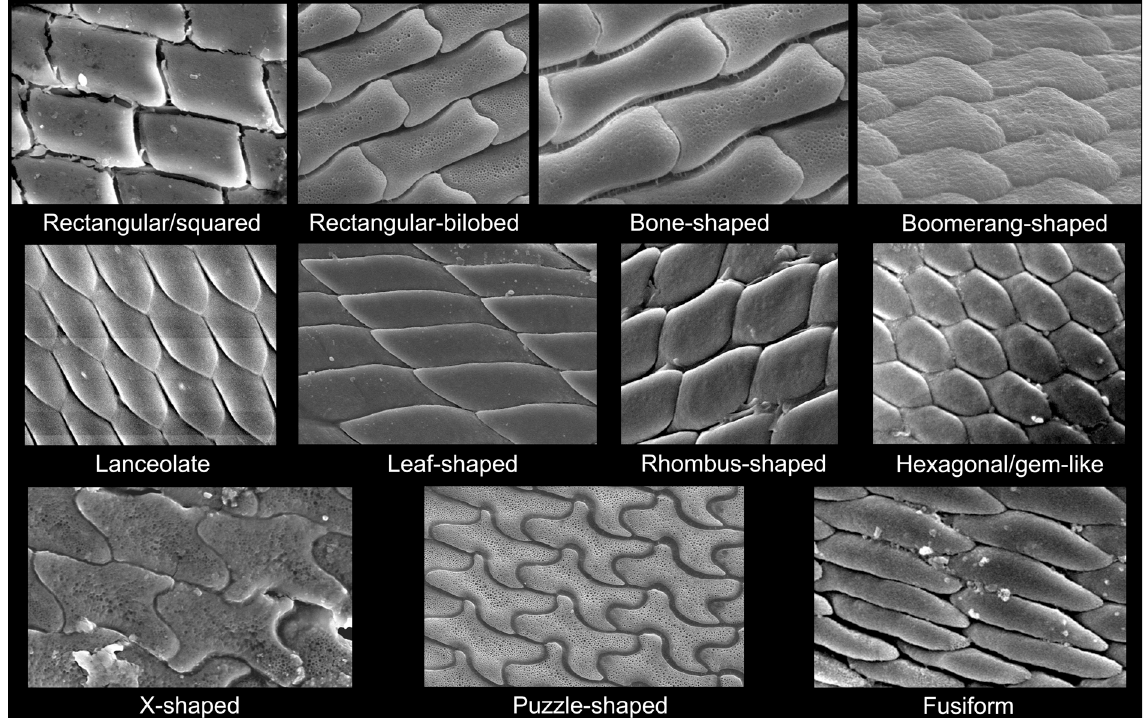
Fig. 1. Main types of jaw scales of